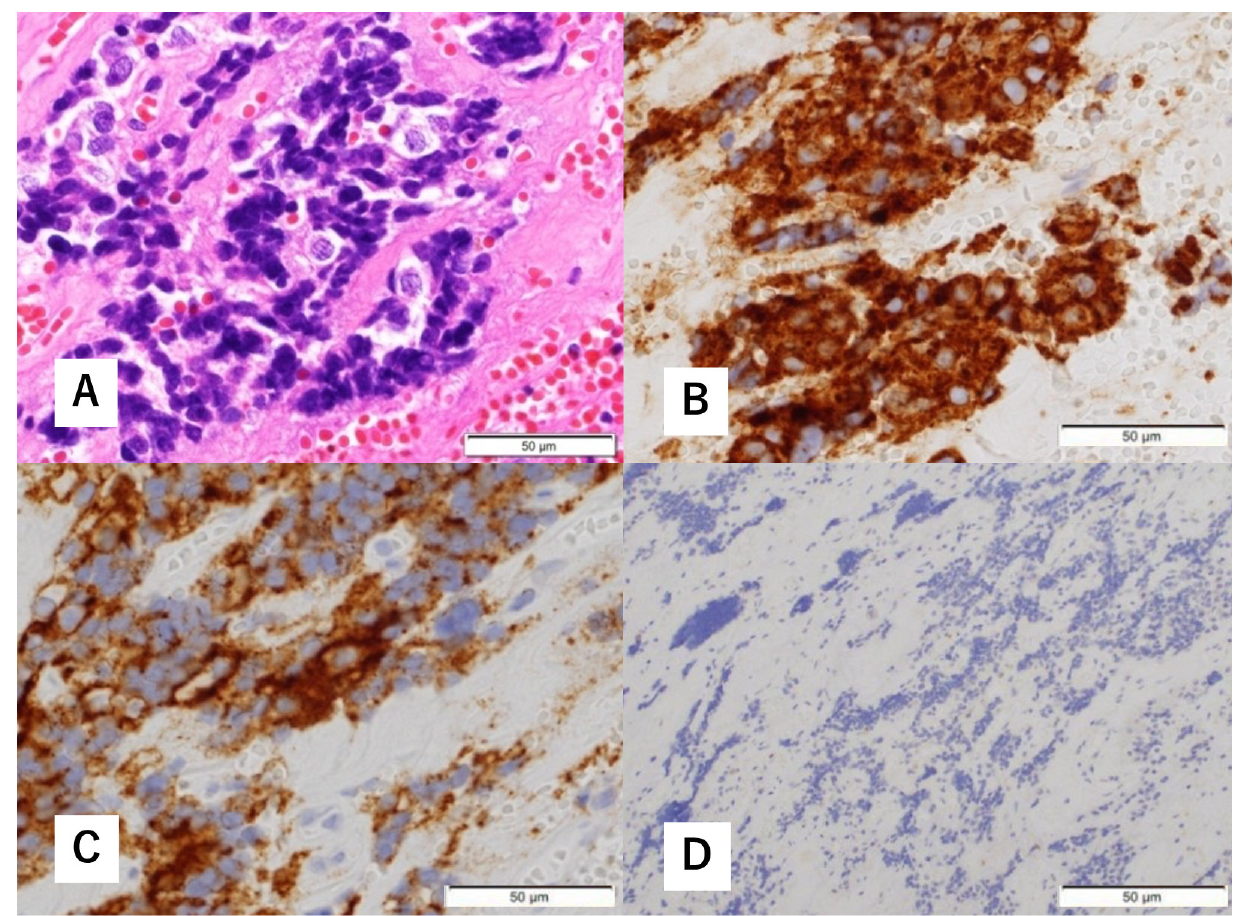
Figure 6. Histopathological findings of excised specimens. H&E staining shows a predominantly crushed artifact ( A ). Immunohistological staining is positive for synaptophysin ( B ) and CD56 ( C ). No S-100 protein-positive cells are observed ( D ).